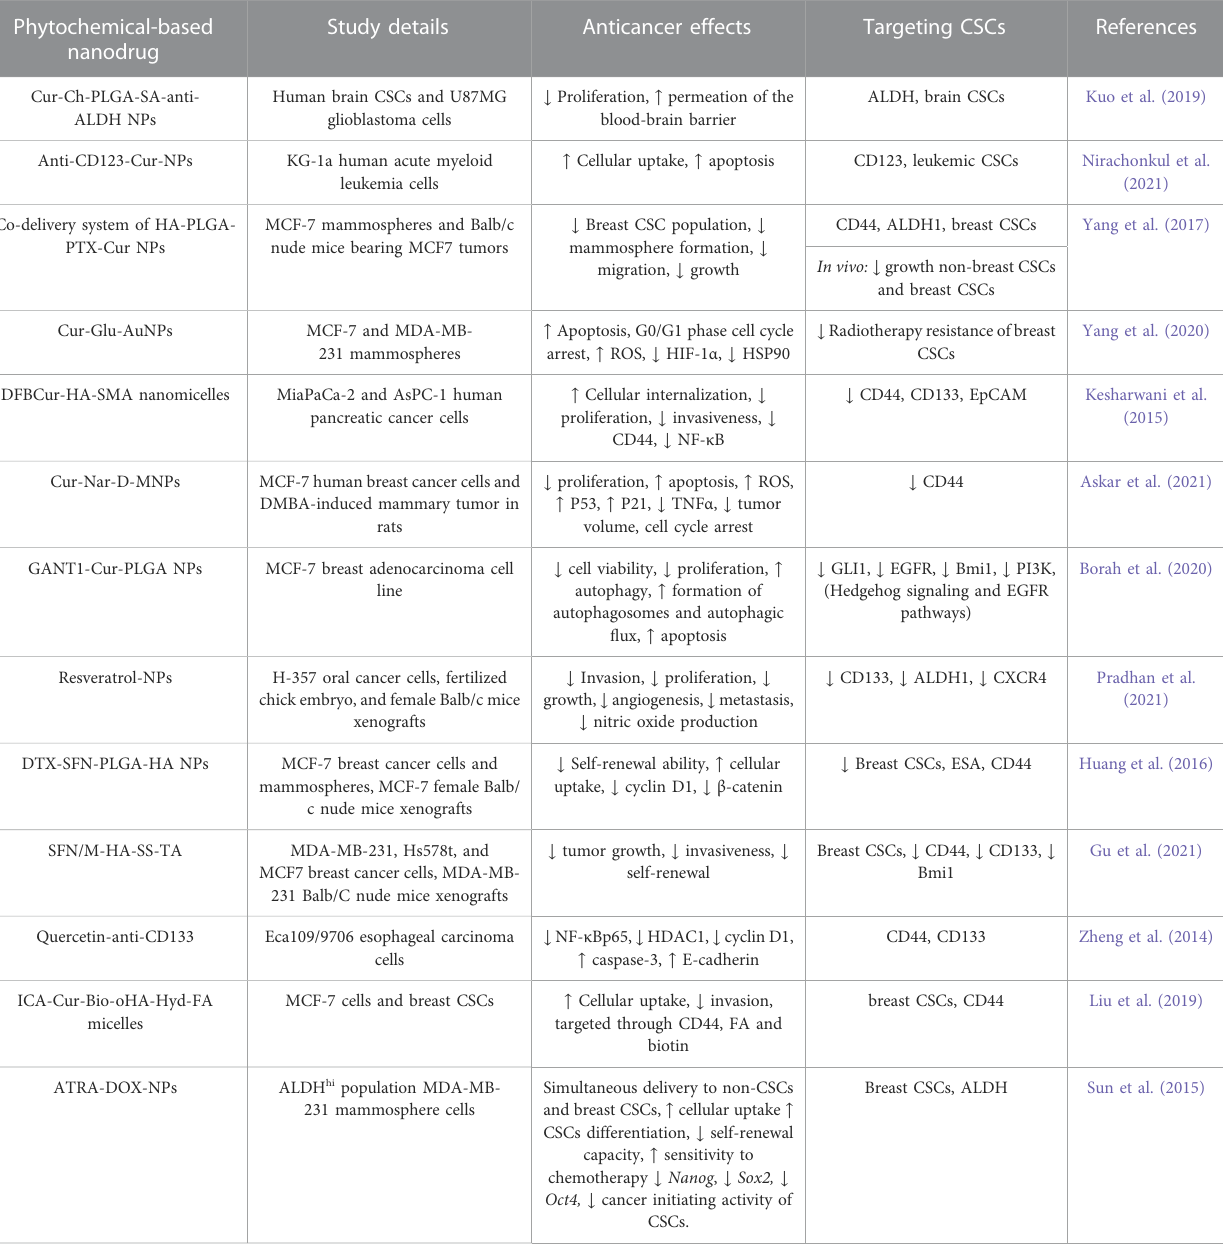
TABLE 3 Phytochemical-based nanodrugs targeting